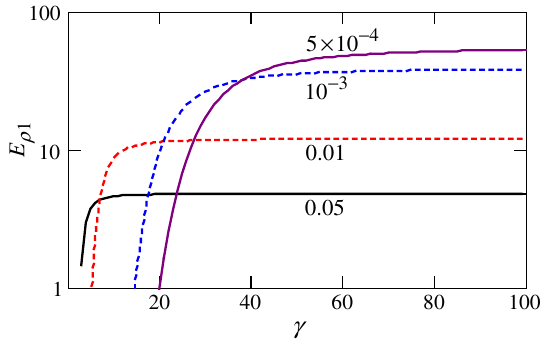
FIG. 3. The exact (solid) and approximate (dashed) magni- tudes of the first mode frequency depending on the Lorentz factor for a ¼ 5 mm and " ¼ 4 ; the values of d=a are given near the curves.